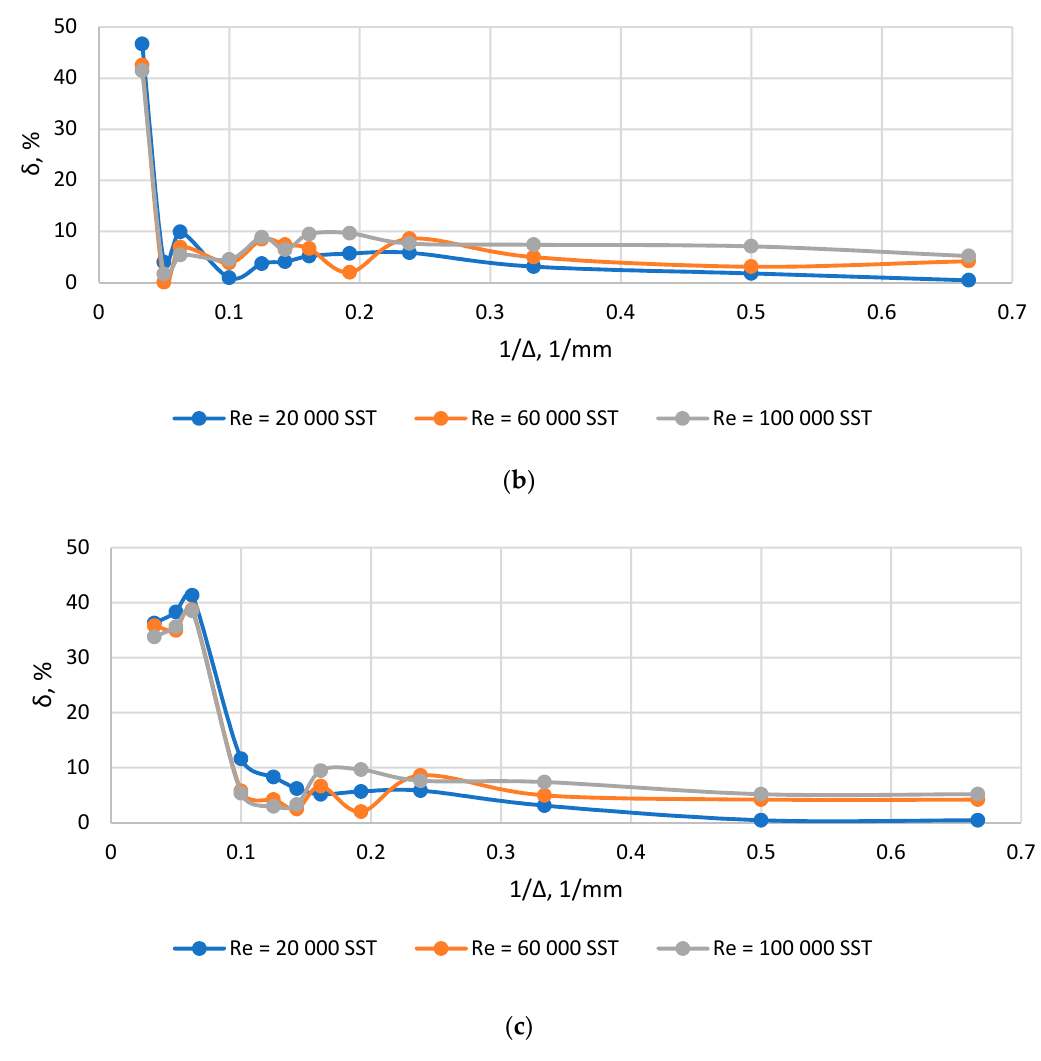
Figure 5. Plots δ (1/ Δ ) for channel with sudden expansion: ( a ) F 0 /F 1 = 0.1; ( b ) F 0 /F 1 = 0.3; ( с ) F 0 /F 1 = 0.5.